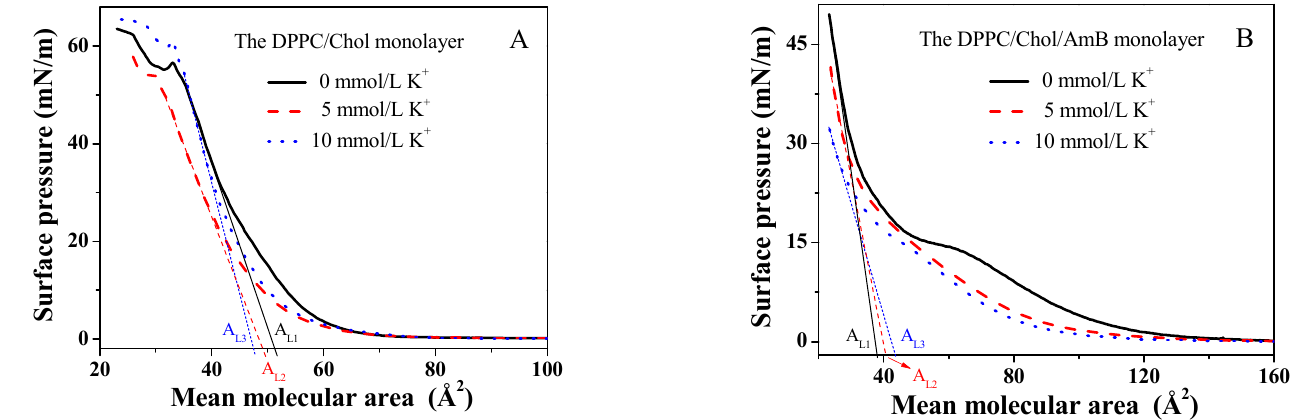
Figure 1. The surface pressure–mean molecular area ( π -A) isotherms of the ( A ). DPPC/Chol mixed monolayer and ( B ). the DPPC/Chol/AmB mixed monolayer at the air–water interface in the absence and presence of potassium ions (5 mmol/L and 10 mmol/L).